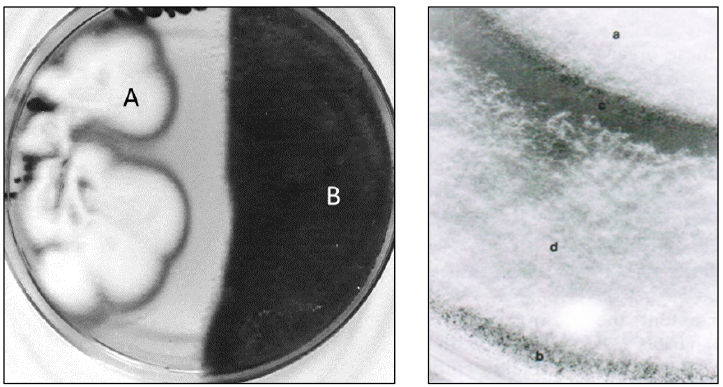
Figure 6. Left: dual culture of L. muscarium ( A ) and Botrytis cinerea ( B ). Right: detail of a dual culture of L. muscarium ( a ) and Mucor plumbeus ( b ); ( c ) contact zone between the two fungi; ( d ) overgrowth of L. muscarium on M. plumbeus (Right: unpublished picture related to [43]. Left: picture modified from [43]).